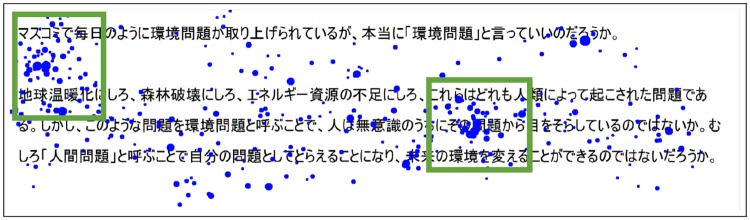
Example of recording: The reader struggled with two parts of the text but read the rest more smoothly.The understanding information of these two parts of the text is included in the eye gaze but not in the question.